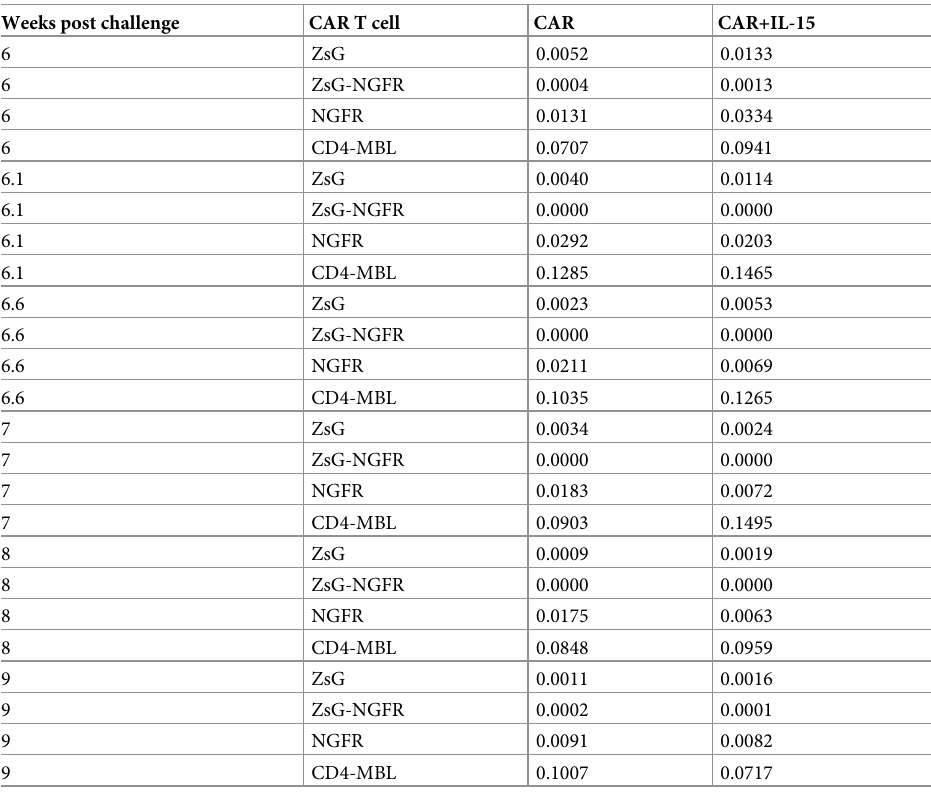
Table 1. CAR T cell frequency in PBMC.